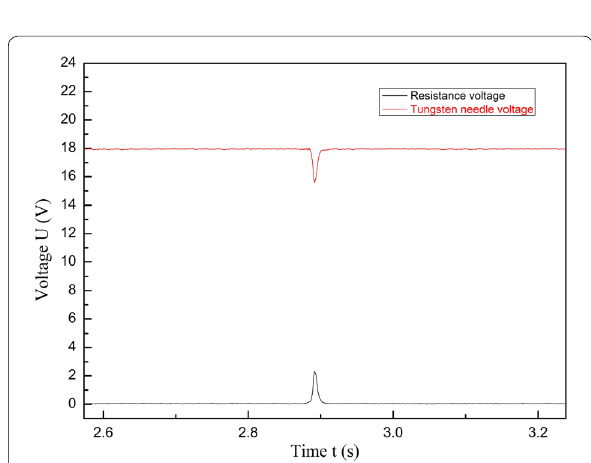
Figure 5 Enlarged graph of the probe voltage and the voltage waveforms of the resistance